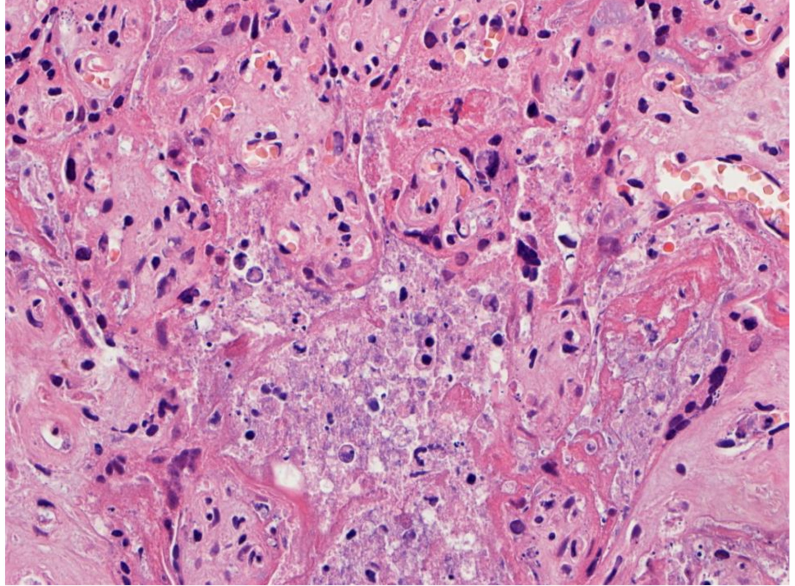
Figure 5. This placenta was infected with SARS-CoV-2 and demonstrates necrosis of the villous trophoblast. The intervillous space is complete obstructed with fibrin, remnants of histiocytes, and cellular and karyorrhectic debris, preventing maternal blood flow and oxygen delivery to the villi. Hematoxylin & eosin staining, × 20. Photograph courtesy of Fabio Facchetti, MD,